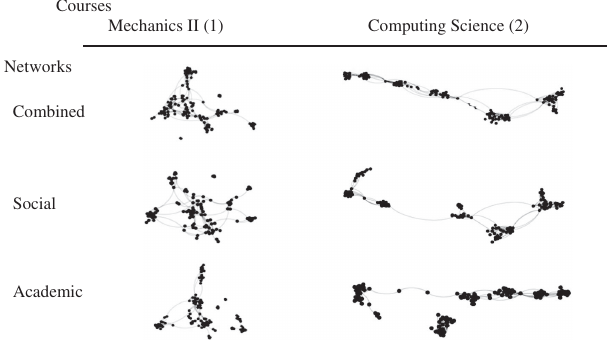
FIG. 2. Network visualizations of the combined, social, and academic networks of Course One and Course Two students.